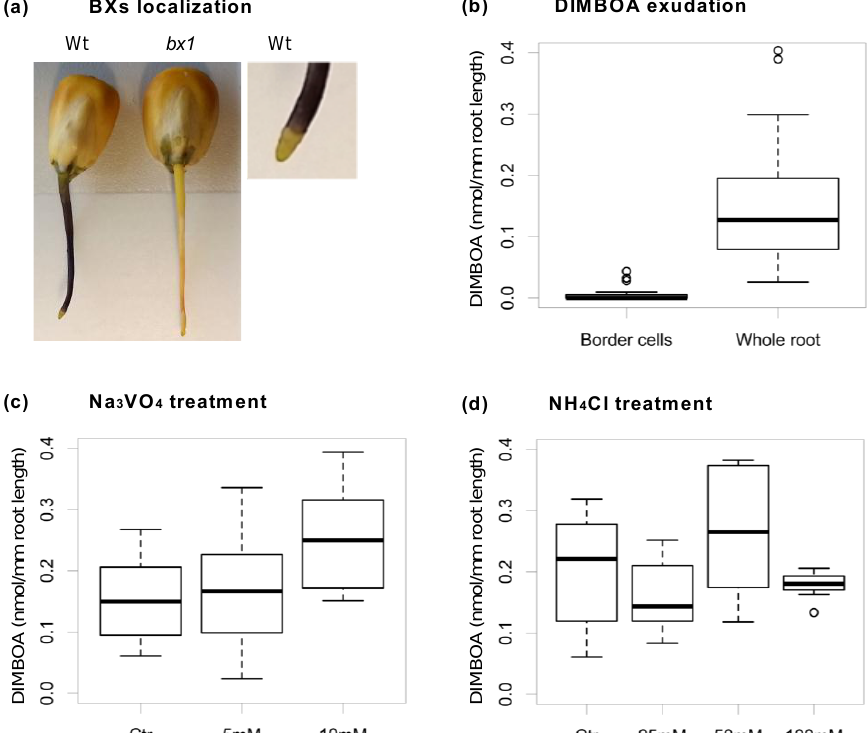
Figure 2. BXs exudation in young maize seedlings. ( a ) Detection of BXs by staining with FeCl 3 . BXs form a blue-coloured complex with Fe (III). The benzoxazinless ( bx1 ) mutant root does not show any staining while the wildtype (WT) root is stained, except for the root cap, suggesting that the root cap is not involved in BXs biosynthesis and exudation. ( b ) DIMBOA amounts in exudate of the root cap border cells compared to the whole root ( n = 16). Border cell exudate was collected by dipping the root tip in 100 µ l of water, while whole root exudate was collected by washing the root with 100 µ l of water. Only very low amounts of DIMBOA were detected in the border cell exudate. ( c ) Effect of Na 3 VO 4 (inhibitor of ATP-binding cassette (ABC)-type transporters) on exudation. No significant inhibition of exudation was observed after treatment with 5 mM or 10 mM Na 3 VO 4 (6 < n < 9). ( d ) Effect of NH 4 Cl (inhibitor of multidrug and toxic compound extrusion (MATE)-type transporters) on exudation. No significant inhibition of exudation was observed after treatment with 25 mM, 50 mM, or 100 mM NH 4 Cl (6 < n < 7)